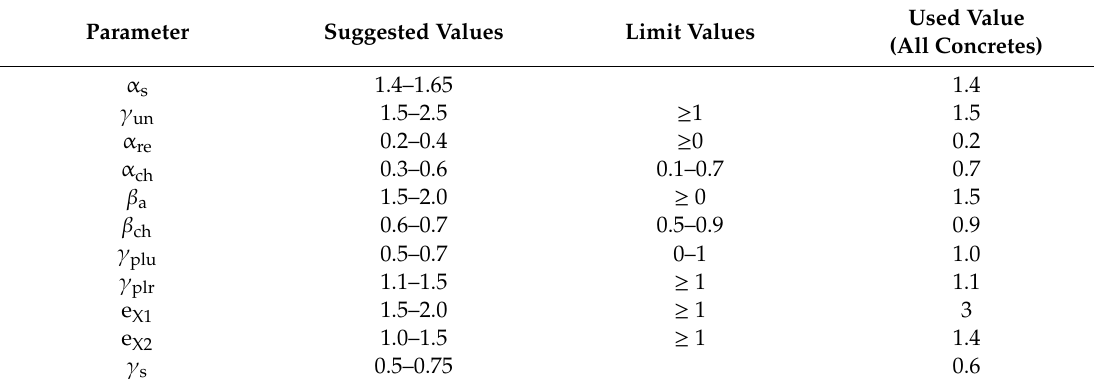
Table 9. Empirical